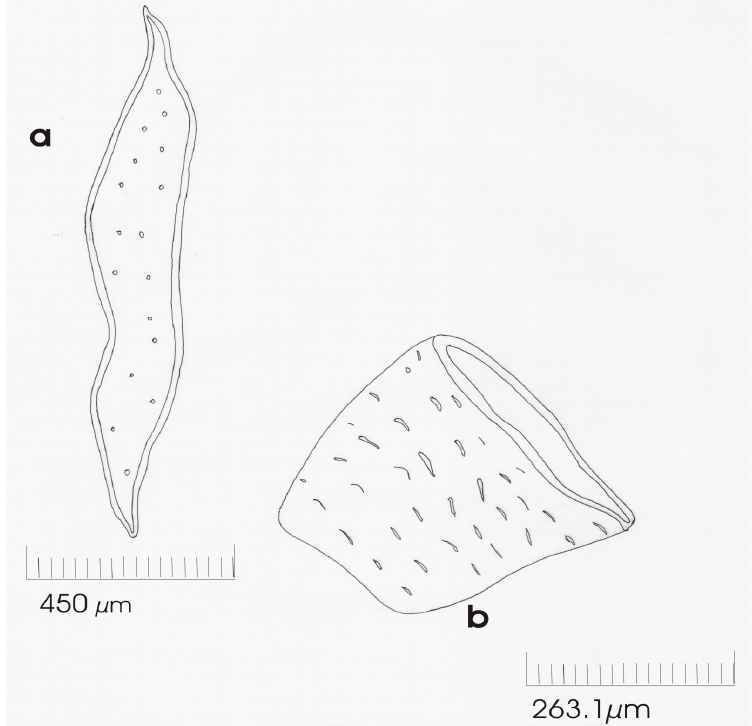
Fig. 8. Annona reticulata ; (a) Fibre tracheids and (b) wide